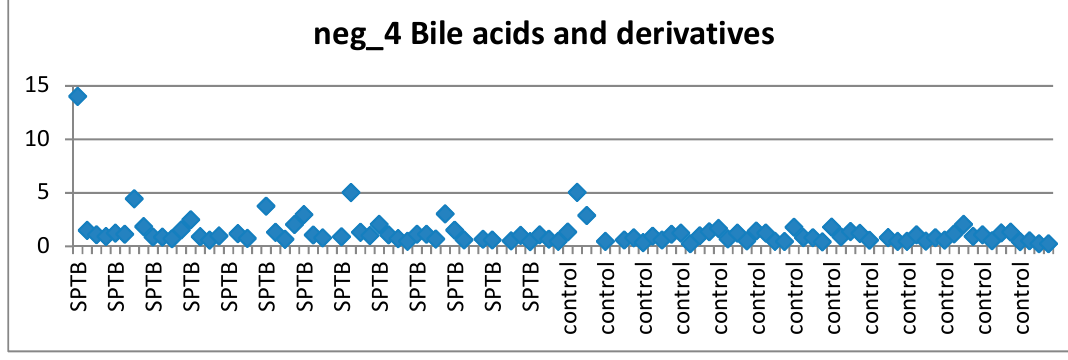
Figure 6. Distribution of feature neg_4 (Bile Acid) across cases and controls.